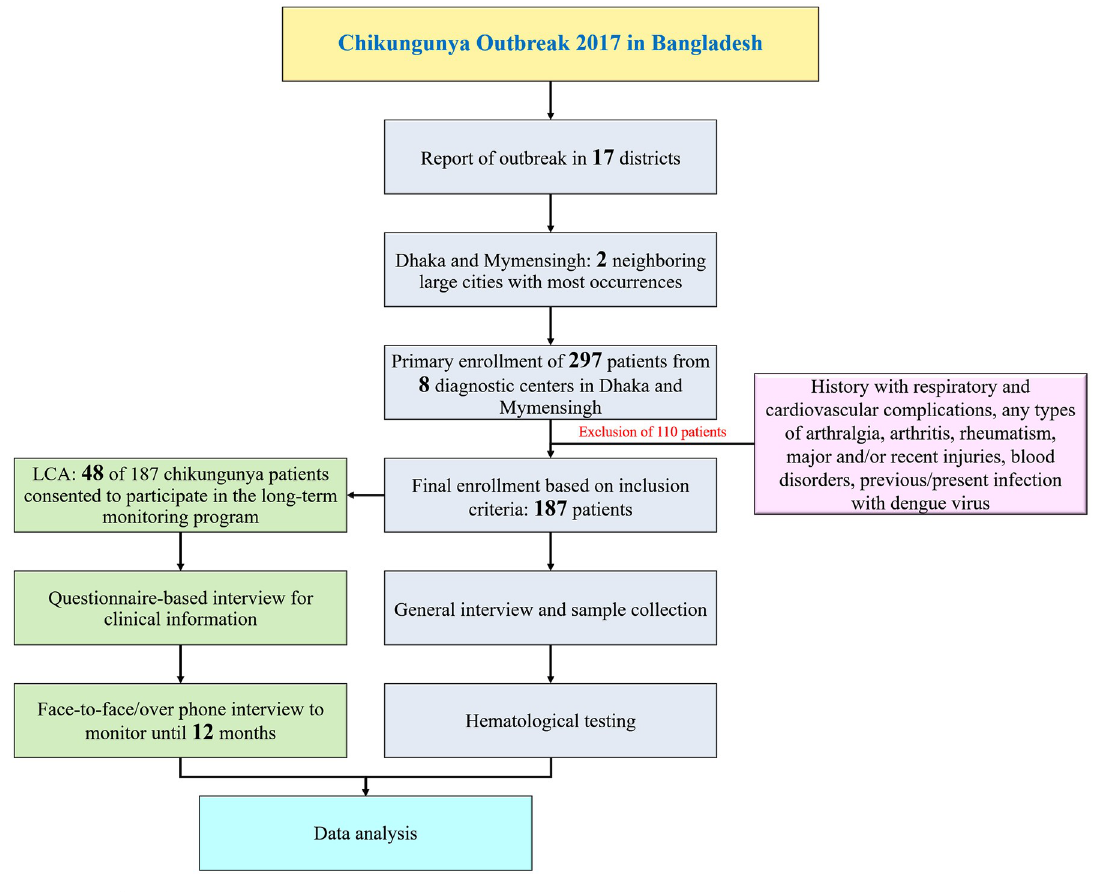
Fig 1. Study flow